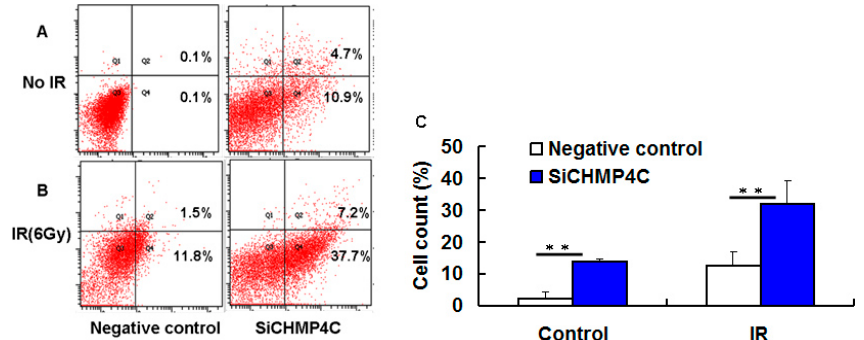
Figure 6. CHMP4C silencing increases cell apoptosis with irradiation. ( A ) CHMP4C-defective cells without IR; ( B ) siRNA transfected cells were exposed to 6 Gy of irradiation. ( C ) Quantification of cell apoptosis assays. The data are presented as the mean ± S.E. of three independent experiments. ** p < 0.01